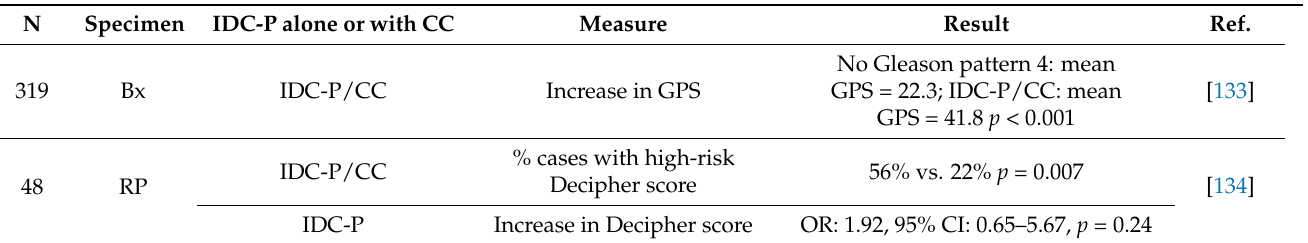
Table 6. Overview of the studies evaluating the association between IDC-P and commercial risk- stratification